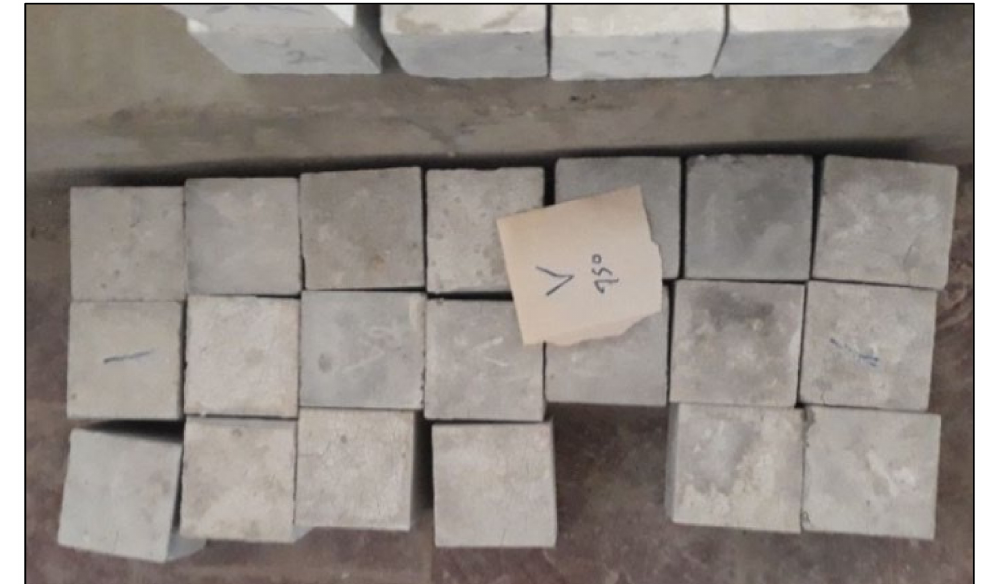
Figure 11. Group V samples after exposure at 750 ◦